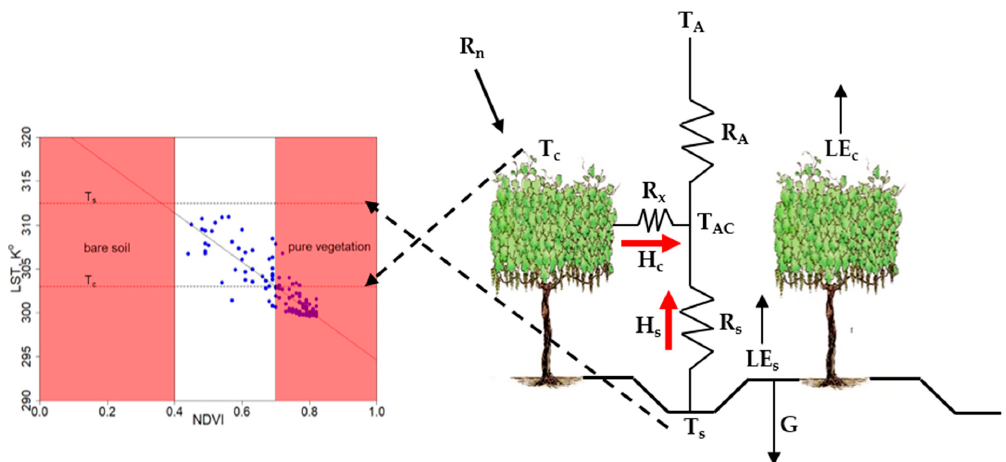
Figure 1. Schematic representation of TSEB2T model.